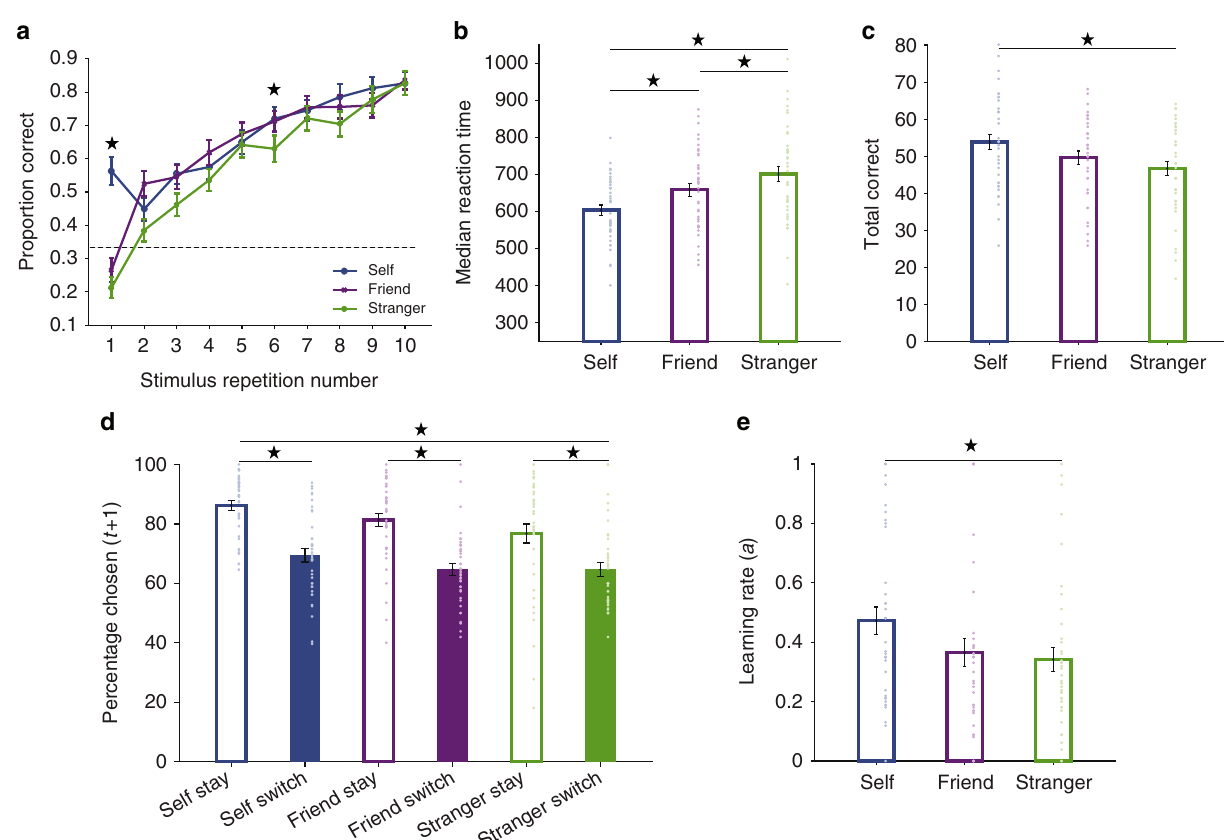
Fig. 2 Self-ownership bias at multiple levels of behaviour. a Learning curve showing the average proportion correct across all participants, averaging across all stimuli. Each stimulus was presented 10 times. A signi fi cant main effect of stimulus repetition ( p < .05) showed that participants were able to learn the stimulus – agent associations across the experimental session. However, a signi fi cant interaction between stimulus repetition×agent (with participants more correct on the fi rst trial for self compared to friend or stranger) indicated a self-bias — a bias to label pictures as belonging to themselves with no prior information (ANOVA p < .05). Note that interleaved at the beginning of the experiment with the stimuli that participants could learn about were six stimuli that were presented only once (and could not therefore be learned: see Methods section). This fi gure does not include the six extra fractals presented only once (see Methods section). Dotted line shows chance performance level (33%). b Participants had faster reaction times for correct responses to self compared to friend or stranger (all conditions signi fi cantly different p <.05). c Participants were overall more correct at assigning ownership to self pictures than to friend or stranger pictures (self signi fi cantly different from both friend and stranger, p < .05). d Learning behaviour showed evidence of both a self- bias and con fi rmation bias with participants more likely to correctly stay and correctly switch after a self choice compared to friend and stranger (main effect of agent, p < .05) and to learn better from correct than incorrect information (main effect of stay/switch, p < .05). Empty bars indicate positive and shaded bars negative feedback on trial t . X-ticklabels indicate correct stay/switch behaviour after agent-speci fi c feedback. e Learning behaviour also showed a self prioritization with higher learning rates for self compared to stranger ( p < .05). Asterisks indicate signi fi cant difference at p < .05. Error bars represent standard error of the mean. All n =